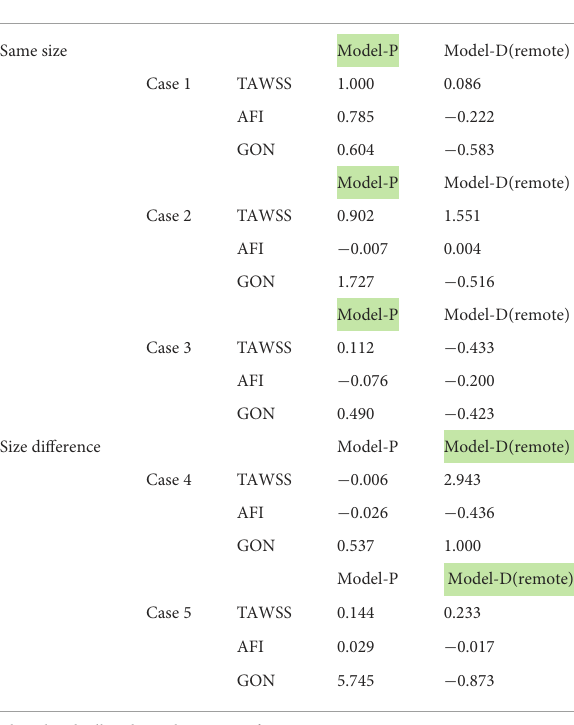
TABLE 3 The comparison of the area-changing ratio of hemodynamic parameters of different pre-aneurysm